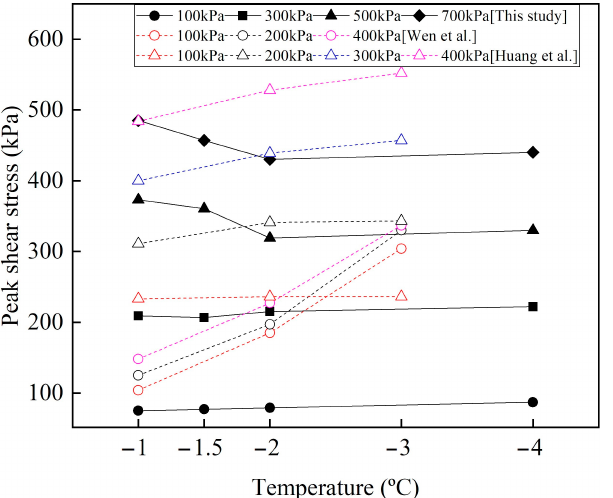
Figure 10. Variation of the peak shear stress with temperature for N = 1 and compared with previous publications [44,45].